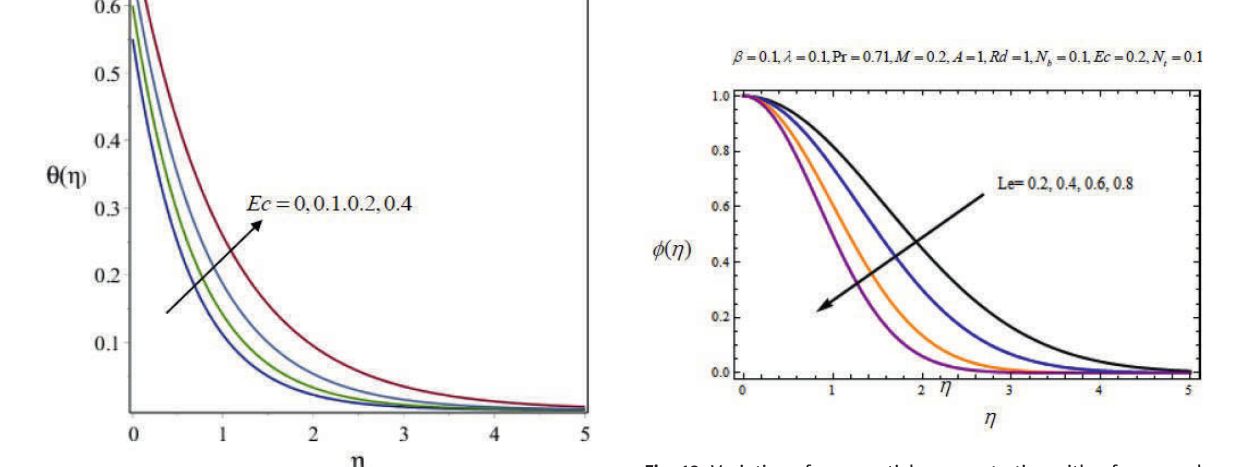
Fig. 19: Variation of nanoparticle concentration with η for several values of Lewis number Le